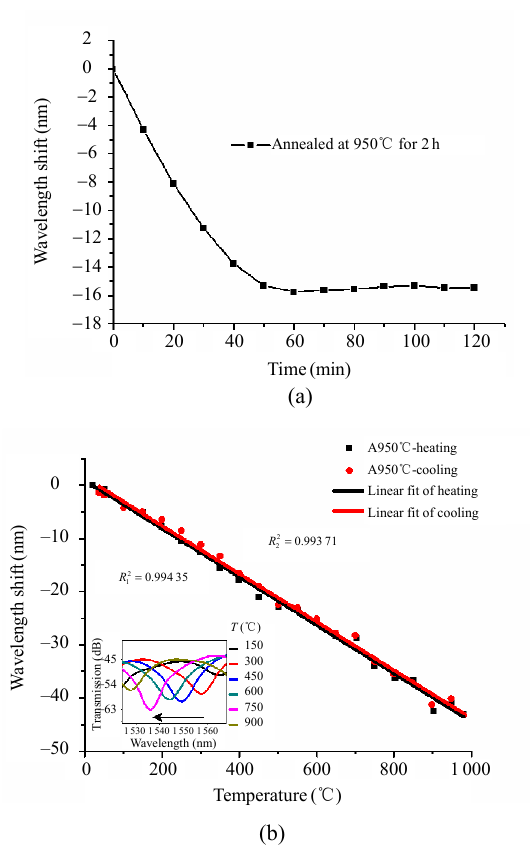
Fig. 9 Process of annealing at 950 ℃ for 2 h: (a) time evolution of the wavelength shift and (b) wavelength shift versus temperature for the FMF sensor after the annealing